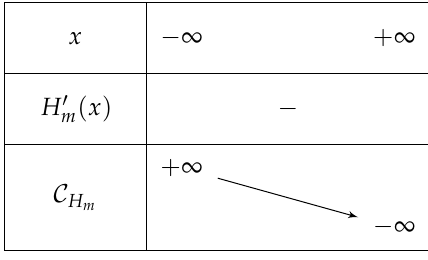
Figure 12. Variation of H m for a